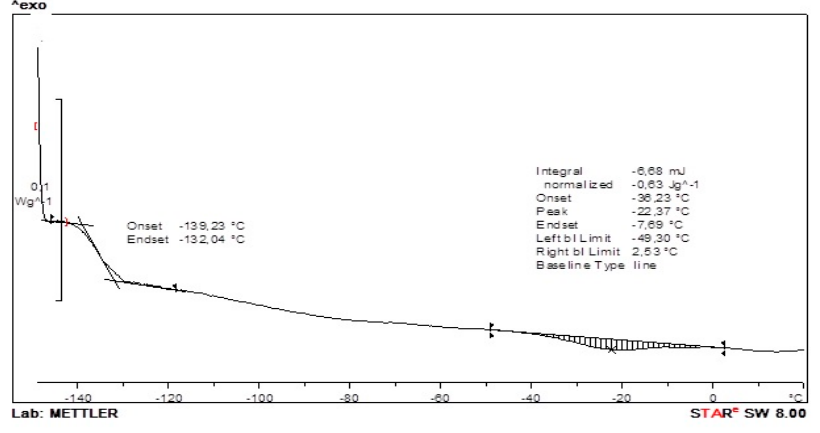
Figure 2. DSC data for fluoropolyurethane 7 .